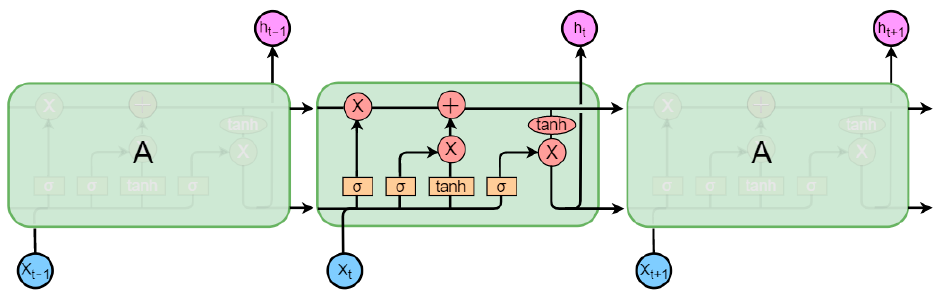
Figure 8. Schematical diagram of LSTM.